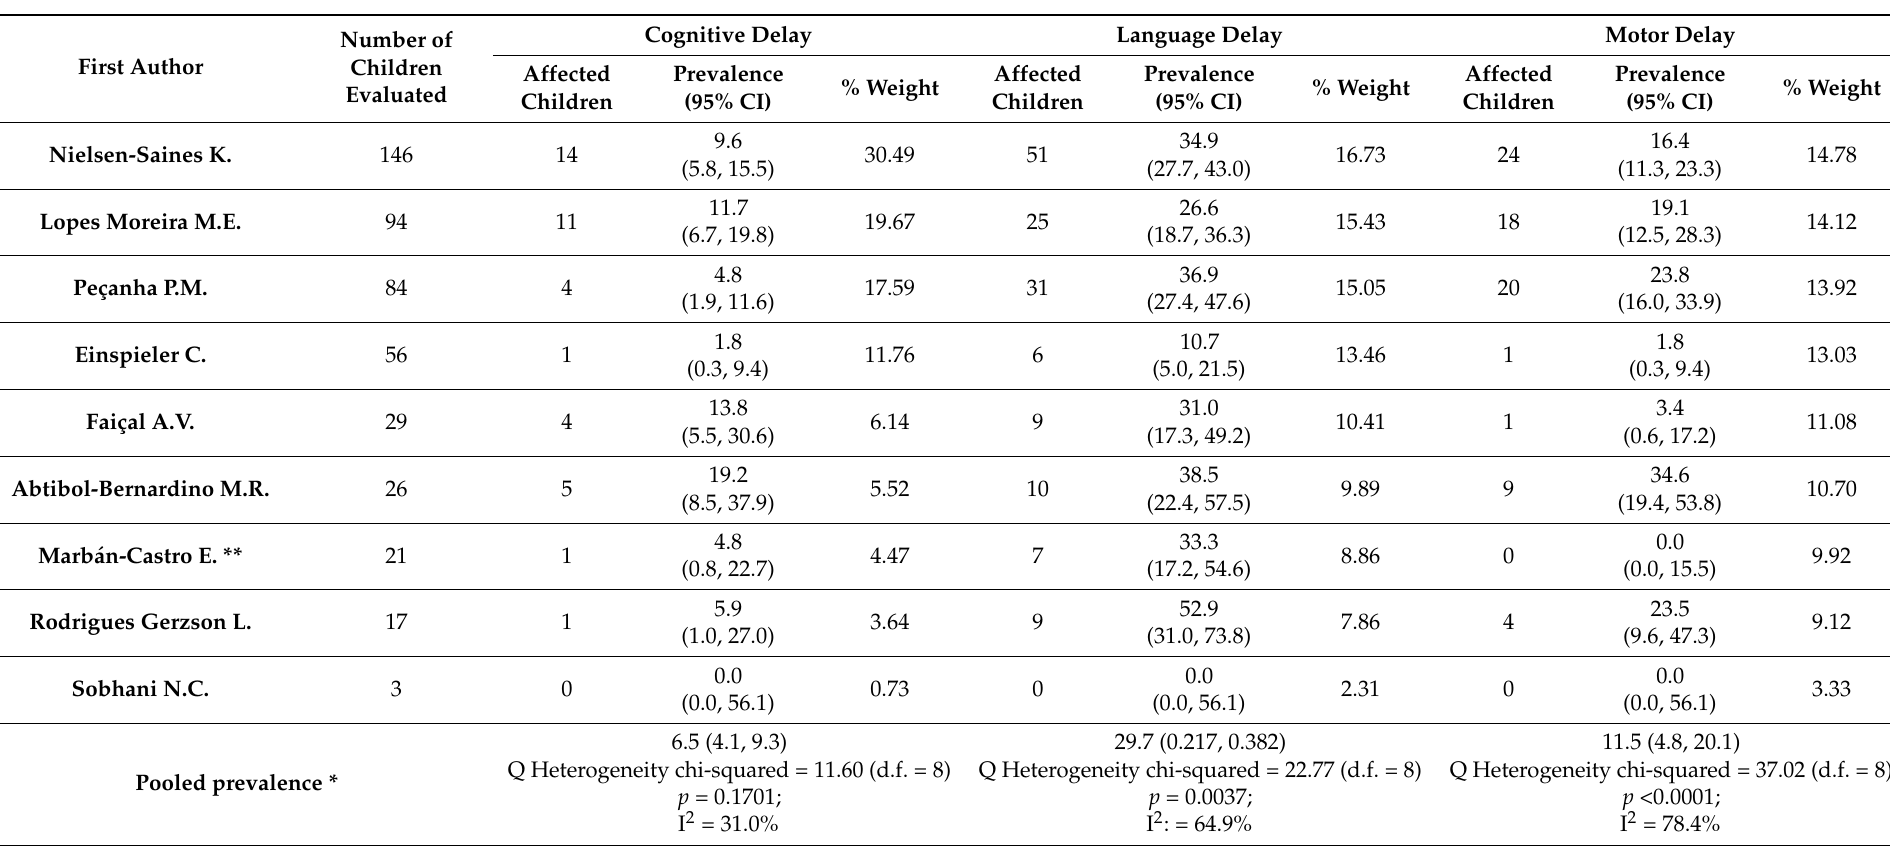
Table 3. Disaggregated data, prevalence, and weight of each study in the meta-analysis for any type of delay in the cognitive, language, and motor domains using the BSID-III